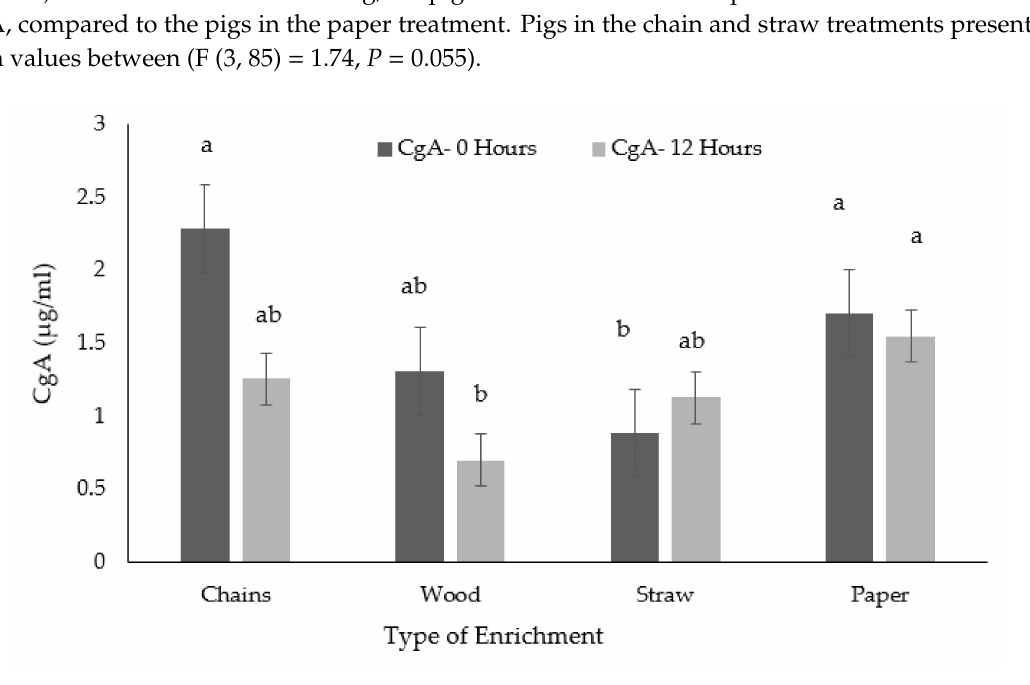
Figure 3. Means (and standard errors) of Chromogranin A for the 4 types of enrichment materials after the two di ff erent fasting times (0 and 12 h). Di ff erent superscripts indicate significant di ff erences due to treatment*fasting